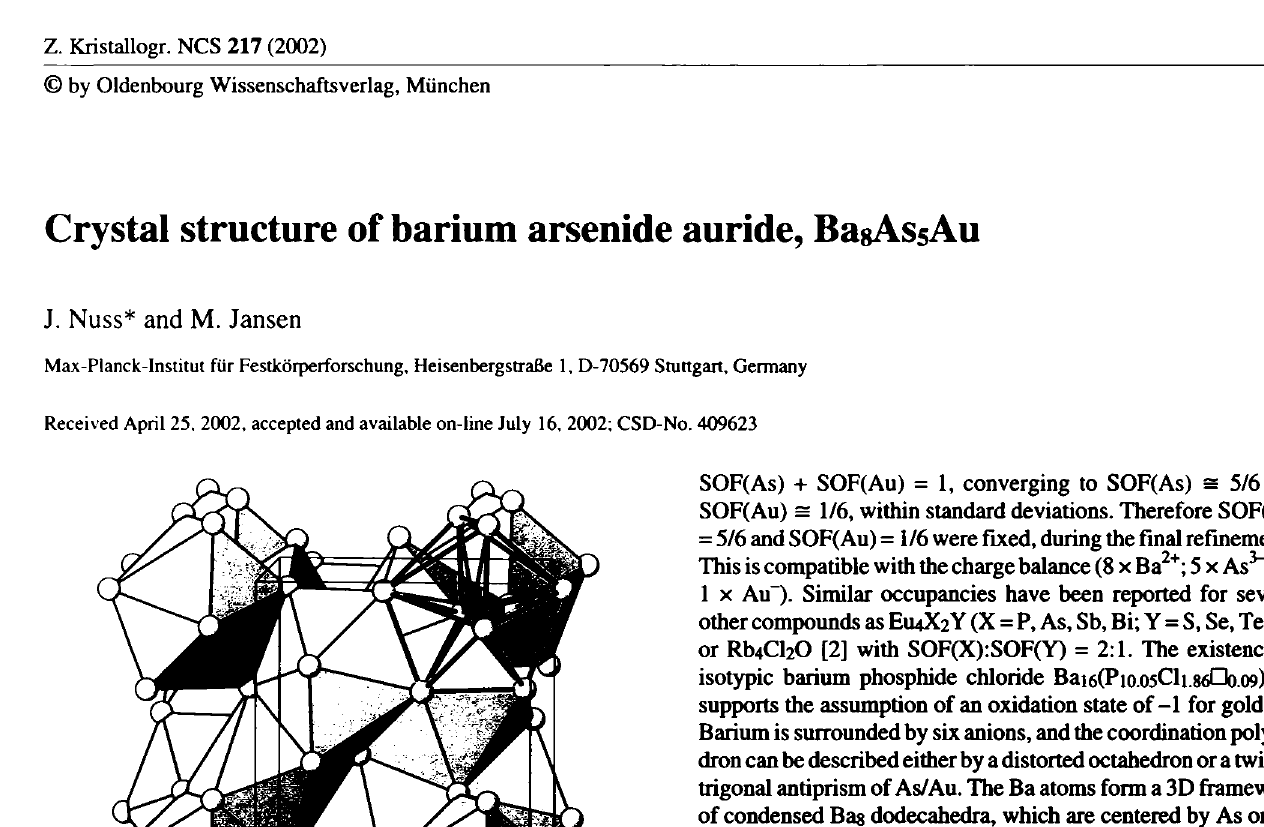
Table 1. Data collection and